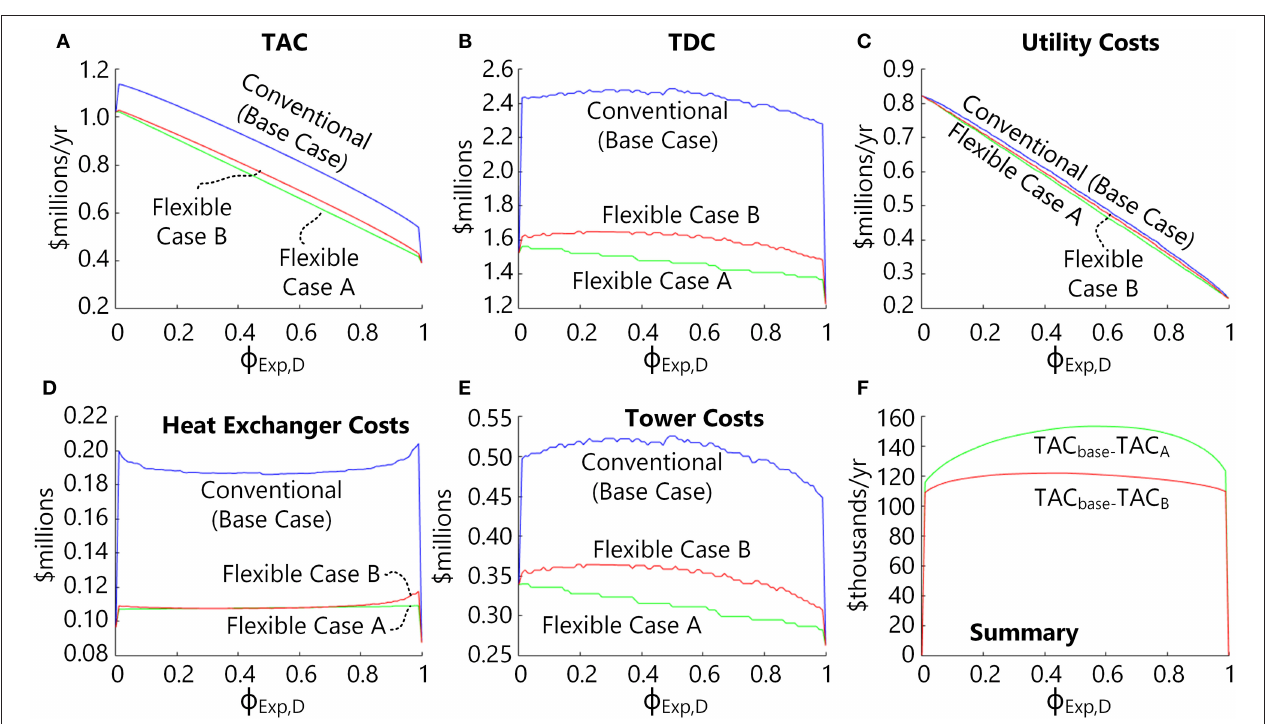
FIGURE 8 | Optimization results for Problem 3 for Flexible Case B as a function of φ Exp , D compared against the Base Case and Case A results (see Figures 4 , 6 ). (A) The expected TAC, (B) the total direct costs, (C) the expected annual utility costs, (D) the total distillation column costs, (E) the total heat exchanger capital costs, and (F) the difference in TAC of the Base Case minus Case A or Case